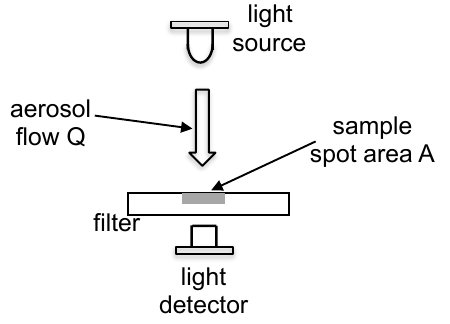
Figure 1. Functional principle of filter-based absorption photome-